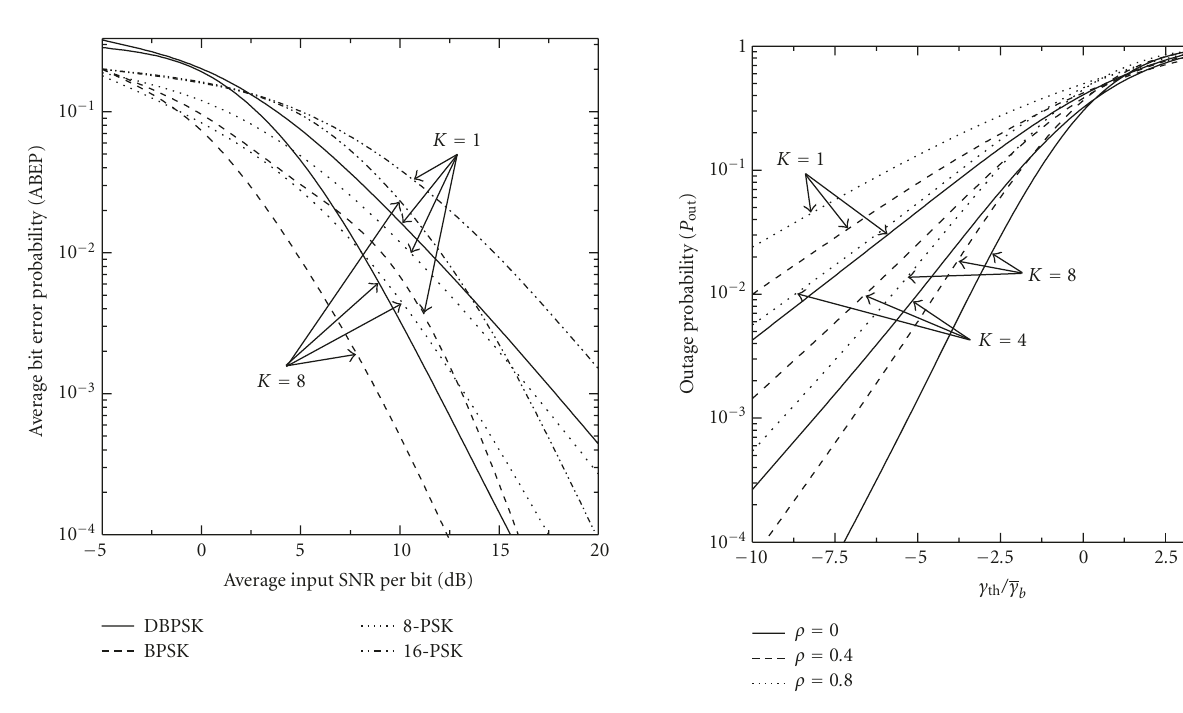
Figure 3: Average bit error probability (ABEP) versus average in- put SNR per bit for DBPSK, BPSK, and M -PSK ( M = 8 and 16) signaling formats, for di ff erent values of the Ricean K -factor.